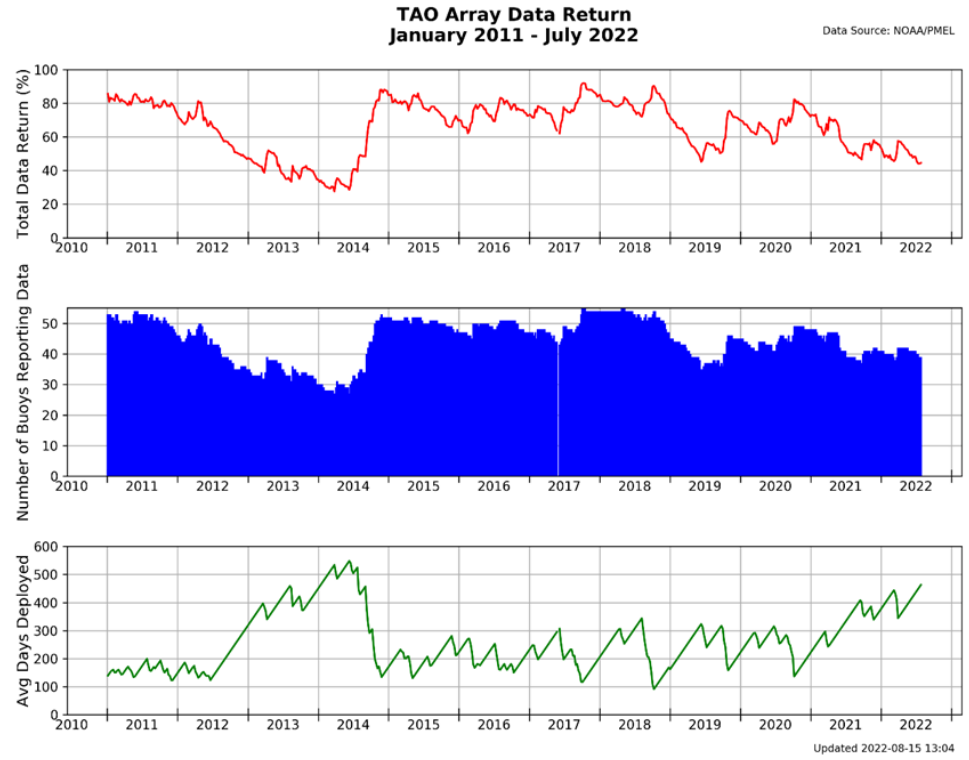
Figure 16. The TAO Array Data Return for 2011 – 2022.